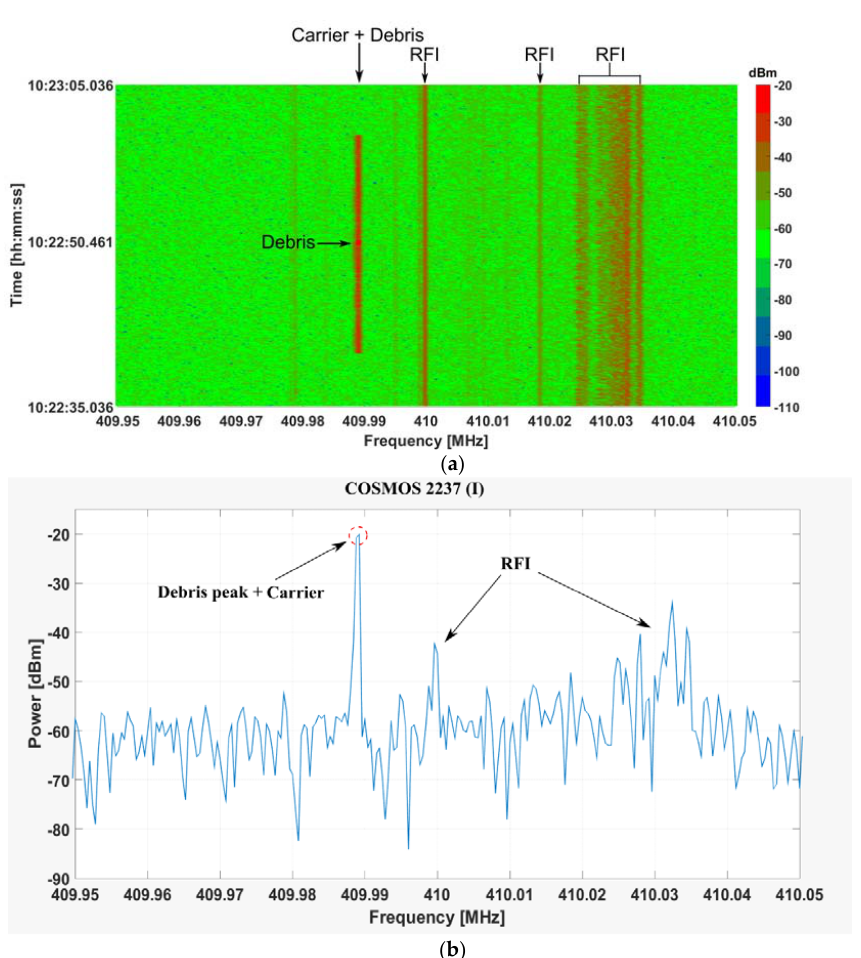
Figure 3. Debris COSMOS 2237 (first passage): ( a ) spectrogram; ( b ) screenshot of the spectrum analyzer at the center of the visibility interval (Table 4).